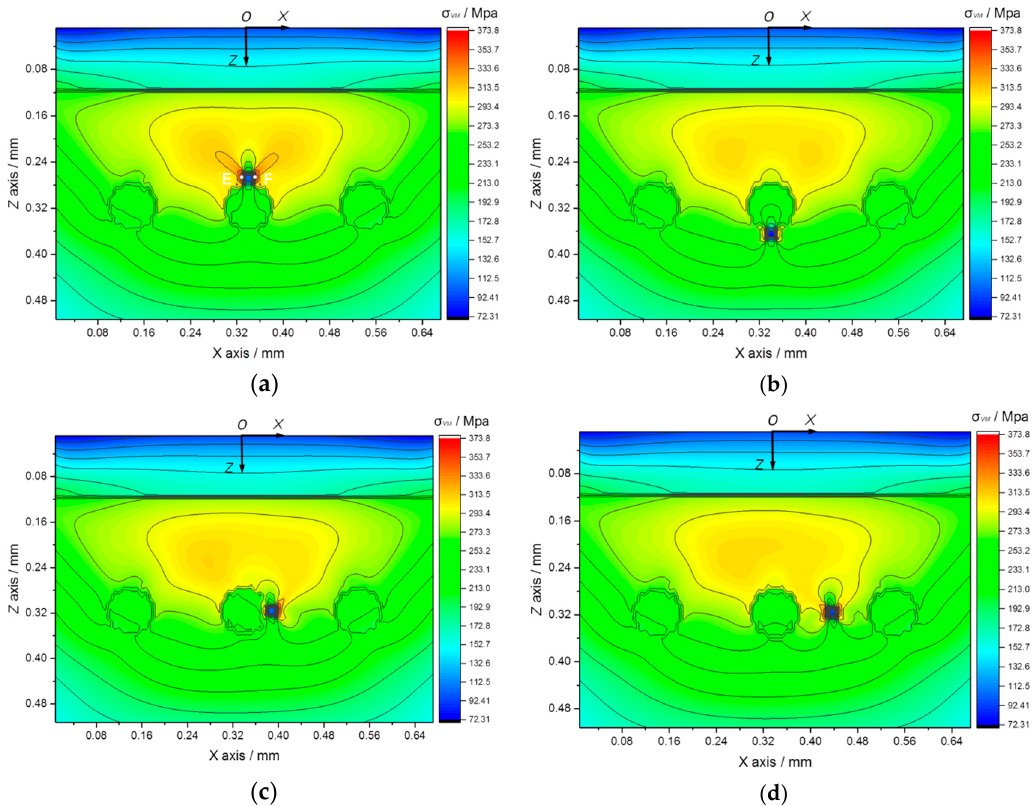
Figure 22. Von Mises stress fields in cross section XOZ with different positions of hole-defect relative to reinforcing SiC fibers: ( a ) above, ( b ) below, ( c ) on the side and ( d ) in the middle between adjacent fibers.